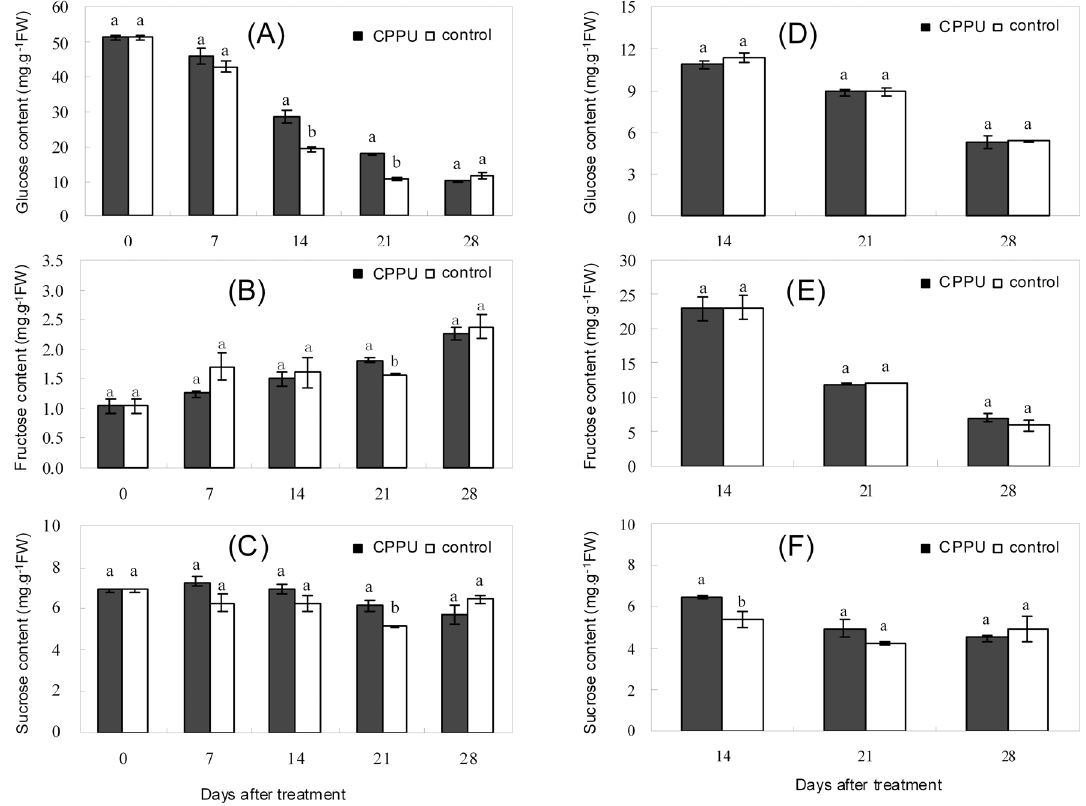
Fig 4. Effect of raceme soaking with CPPU on carbohydrate composition in the husk (A, B, and C) and seed (D, E, and F). Different letters indicate significant difference between the treatment and the control based on t -test ( p < 0.05).